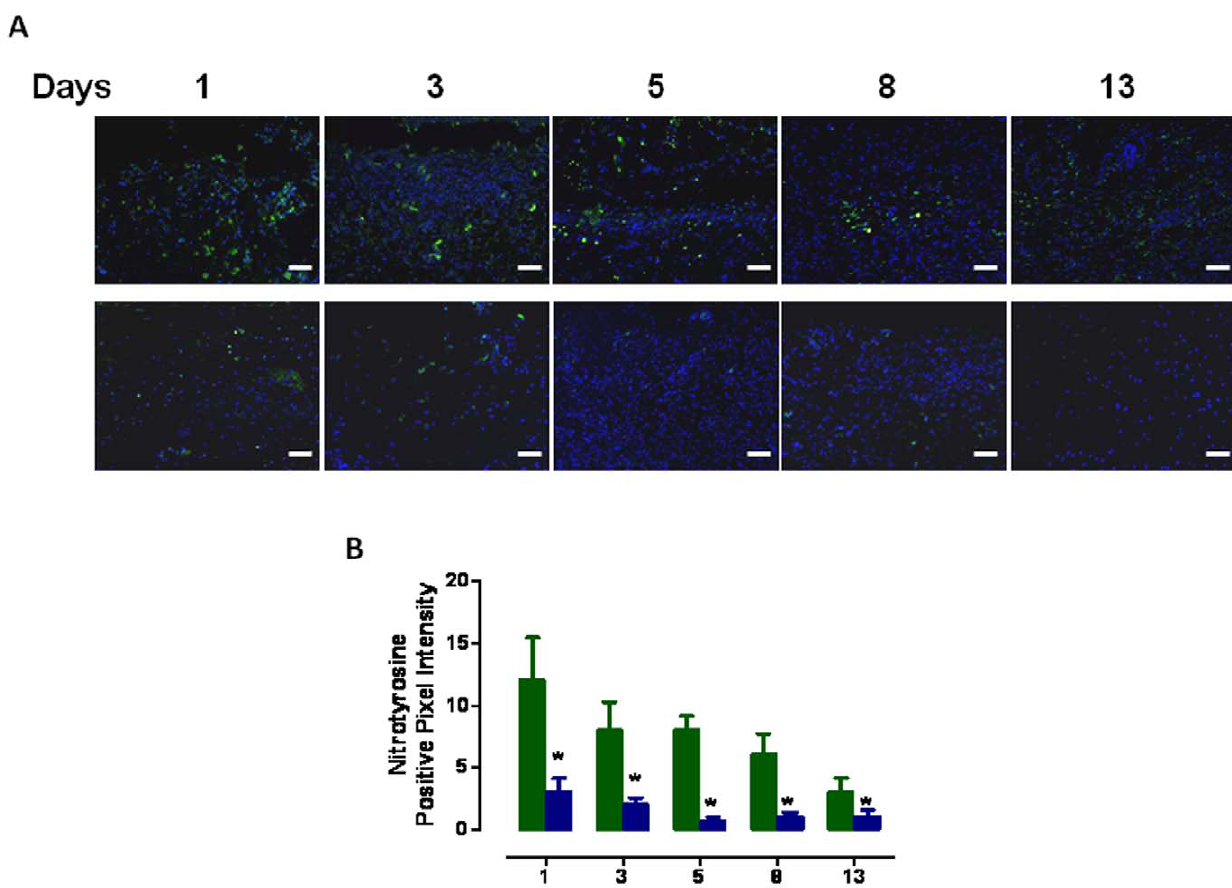
Figure 7. Eight wound halves, control vs. UA2 treated were analyzed by immunofluorescence for the presence of nitrotyrosine positive cells in indicated number of days post-injury. A. Representative images of staining. Nitrotyrosine-positive cells are green in color. Nuclei were counterstained with Hoechst 33342. Scale ba r=50 m m. B. Graph showing the quantification of immunostaining. The percentage of nitrotyrosine positive cells was determined using the IP lab software (BD Biosciences). Statistical analysis was performed two- way ANOVA using GraphPad Prism version 5.00. D. (*P , 0.001).